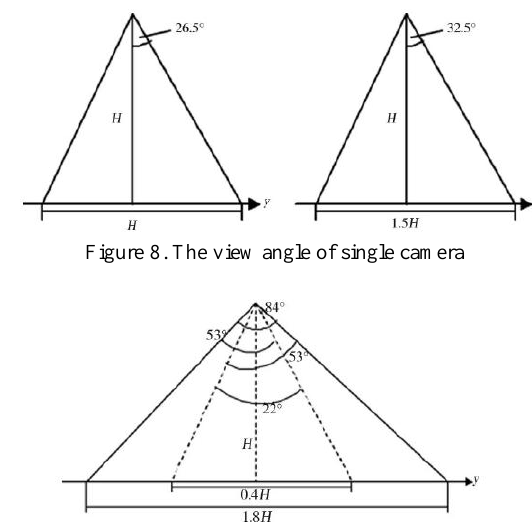
Figure 9. The lateral view angle of double-combined camera